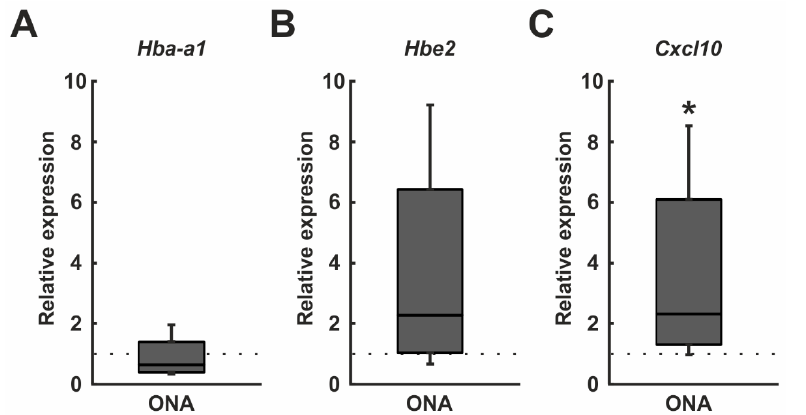
Figure 7. Downregulated regulated oligonucleotide probes. ( A – O ) The 15 oligonucleotide probes found downregulated in ONA rats following microarray analysis of the inner retinal layers. All plots display the normalized fluorescence intensity (y-axis) of ONA and control animals (x-axis). Based on the results of the microarray assays, we performed additional RT-qPCR analyses of the most up- and downregulated genes ( p < 0.05). Amongst others, Hba-a1 ( p = 0.006), Hbe2 ( p = 0.009), and Cxcl10 ( p = 0.039) were found upregulated in the ONA reti- nae in the microarray analysis.